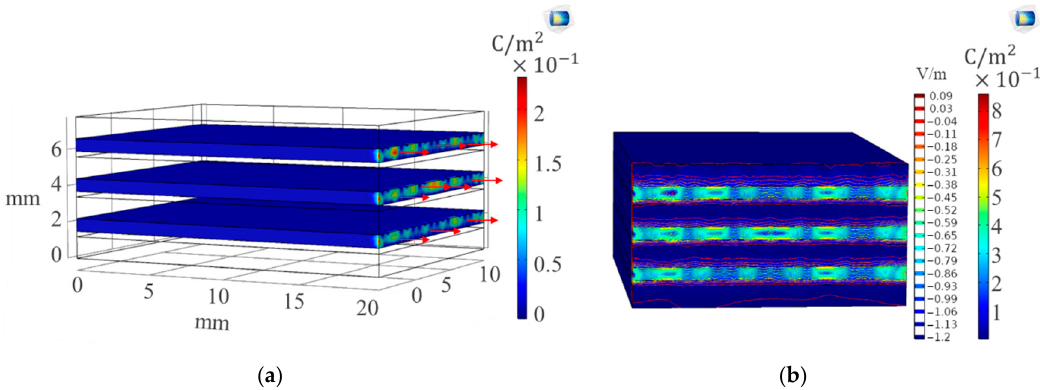
Figure 4. The ( a ) piezoelectric layer polarization (C/m 2 ) and ( b ) electrical field (V/m) layer response.